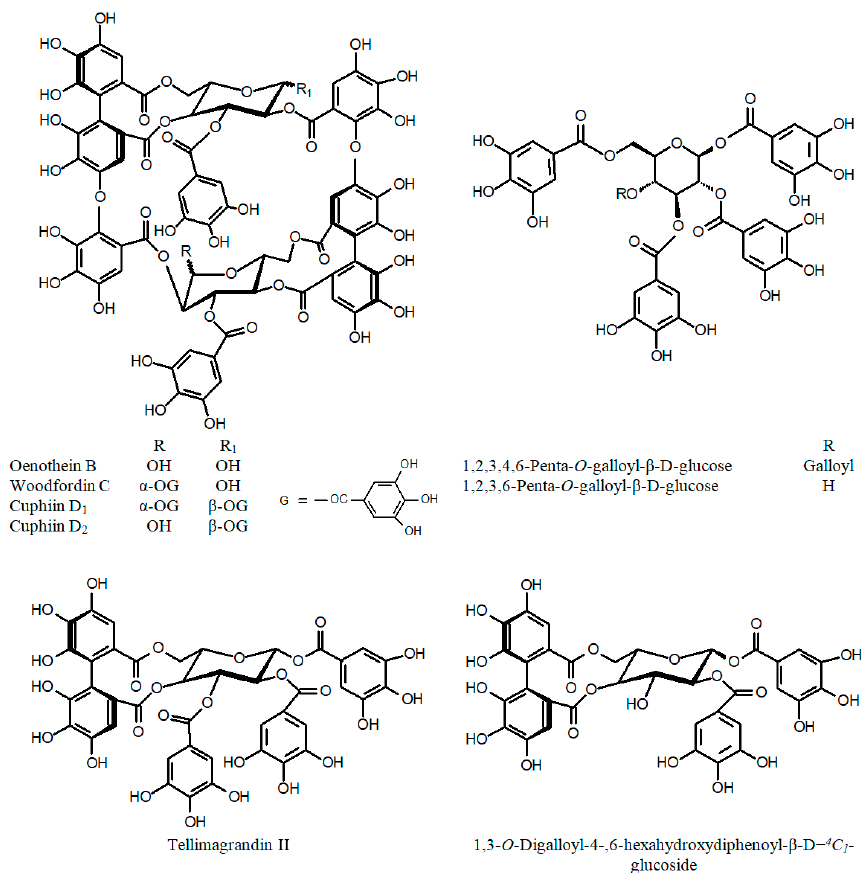
Figure 3. Chemical structures of tannins of the genus Cuphea .